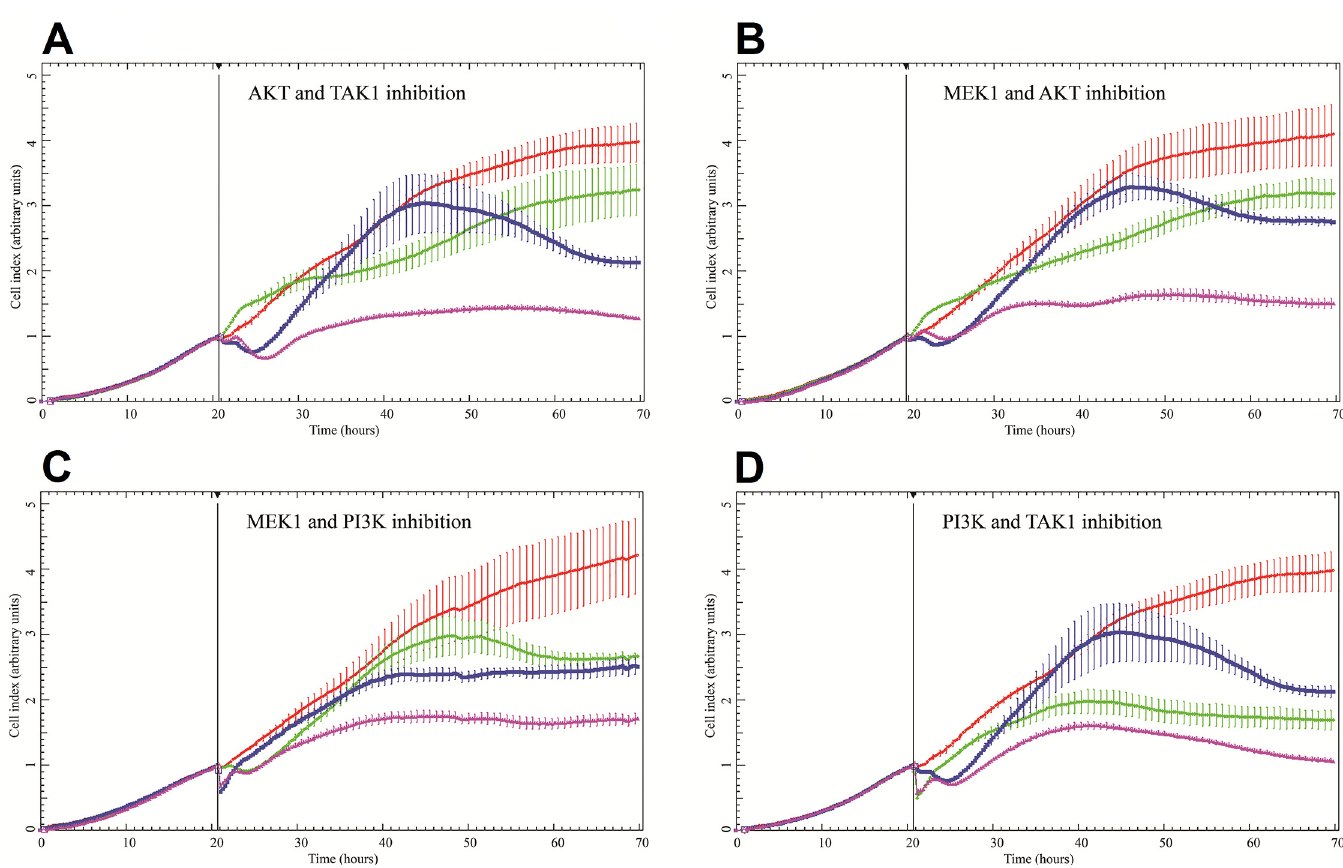
Fig 5. Experimentally confirmed synergies, where the effect of combining two inhibitors at half GI50 concentrations (violet) outperforms each of the single inhibitor at the full GI50 concentration. A) AKT inhibitor (green) and TAK1 inhibitor (blue). B) MEK inhibitor (blue) and AKT inhibitor (green). C) MEK inhibitor (green) and PI3K inhibitor (blue). D) PI3K inhibitor (green) and TAK1 inhibitor (blue). Cells growing in the absence of inhibitors are shown in red. One standard deviation is indicated by error bars. Inhibitors (and concentrations) used: MEK inhibitor PD0325901 (35 nM), TAK1 inhibitor